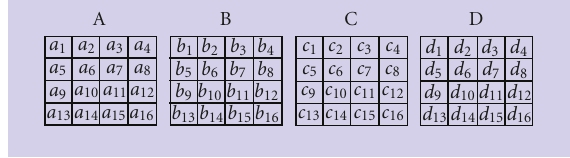
Figure 5: A GOF consisting of four frames.